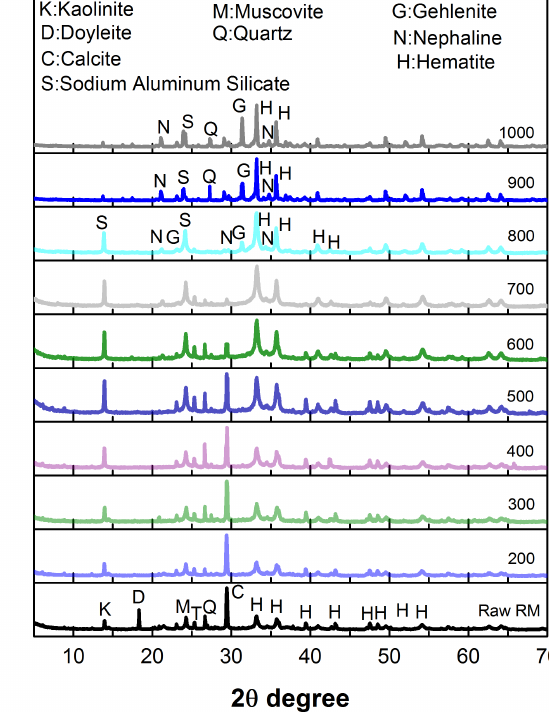
Figure 3: XRD spectra for raw RM and RM samples calcined at differ- ent temperatures from 200 ∘ C to 1000 ∘